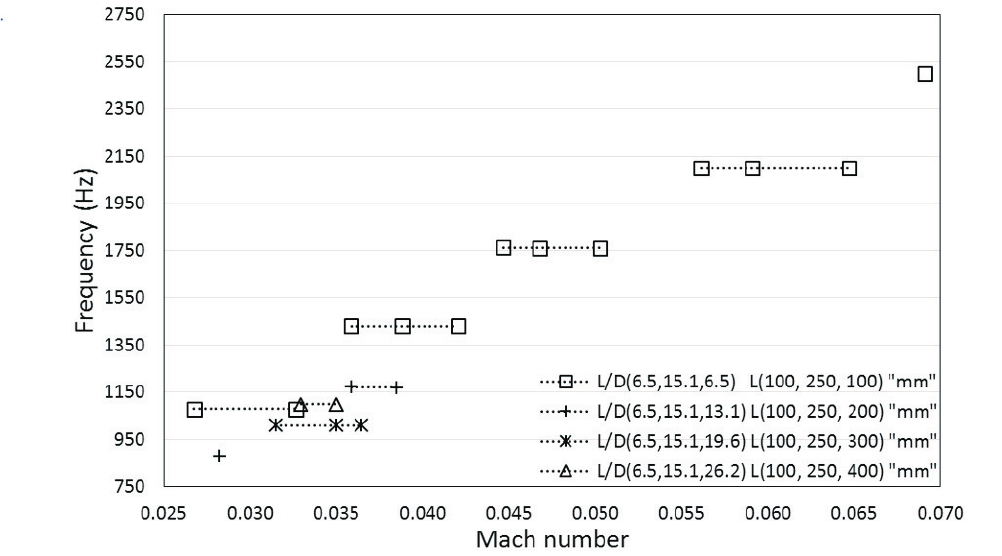
Figure 5. Frequency (Hz) plotted against Mach number M for L up = 100 mm, L corr = 250 mm, and L dw = 100–400 mm. Table 2. Mach number and corresponding frequency range (Hz) for pipe systems in Case